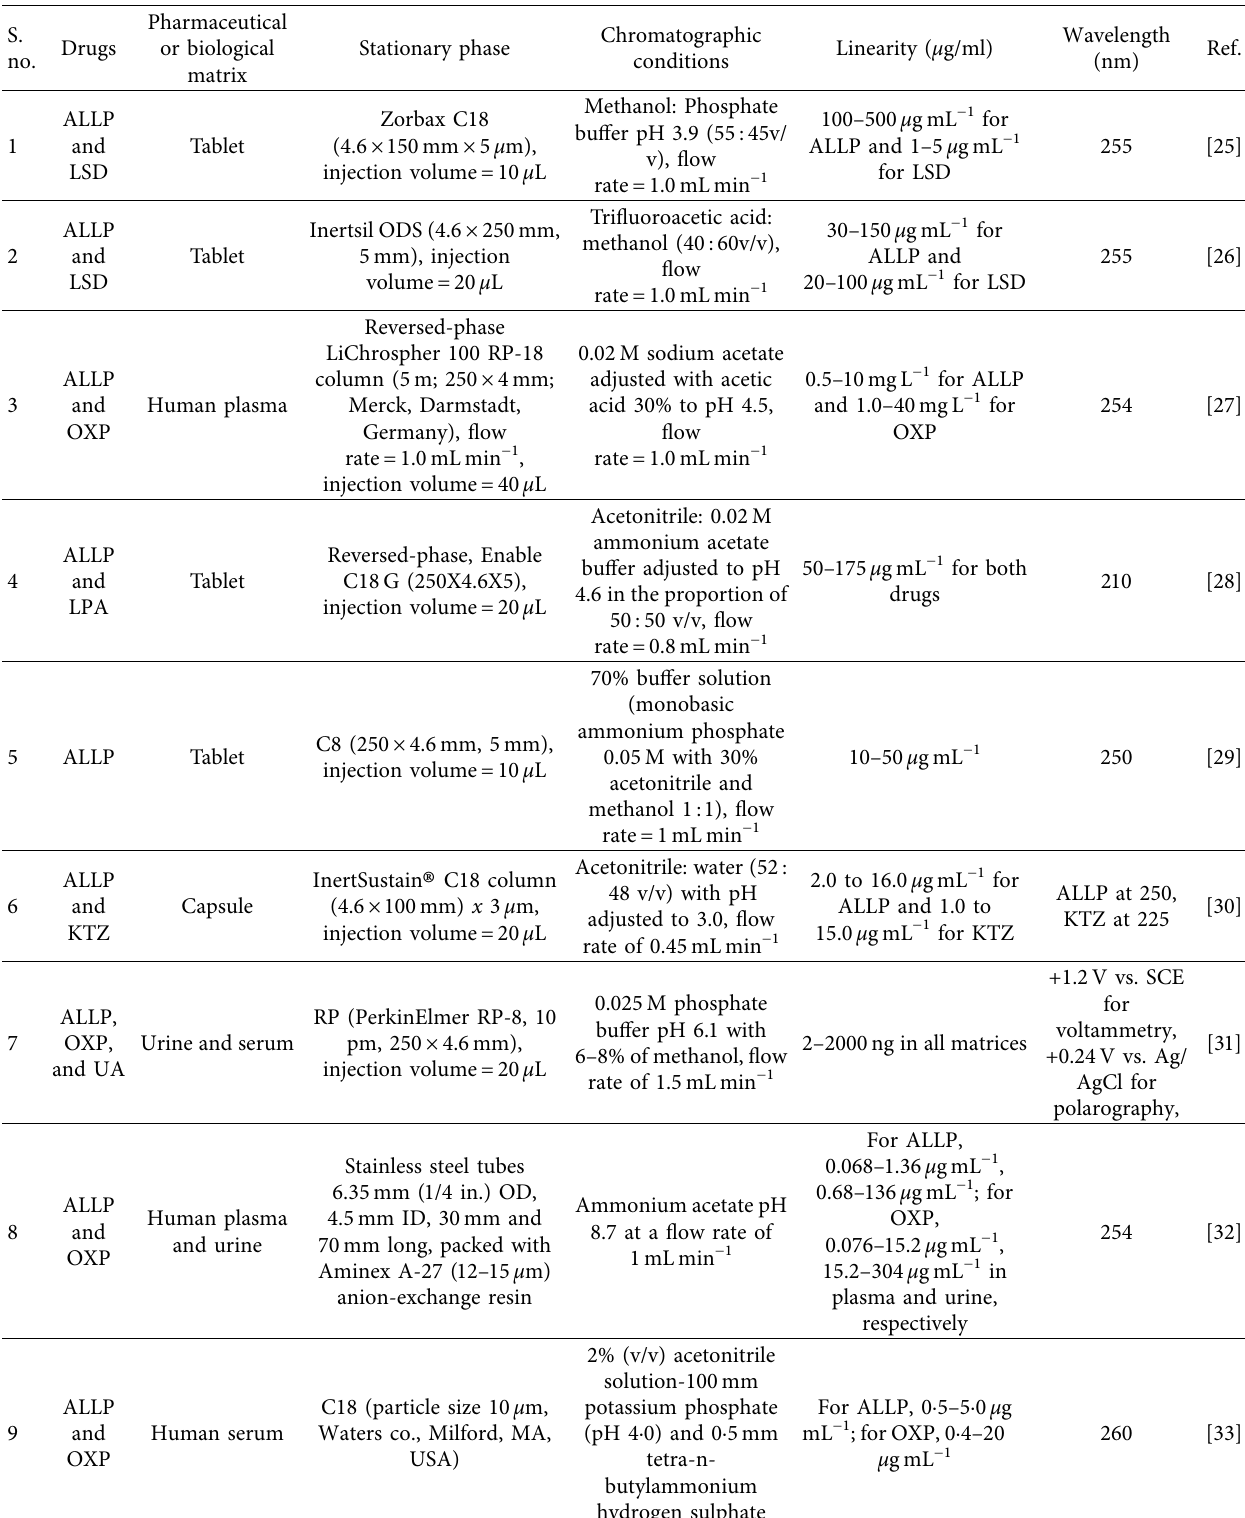
Table 2: HPLC/UPLC methods for the determination of